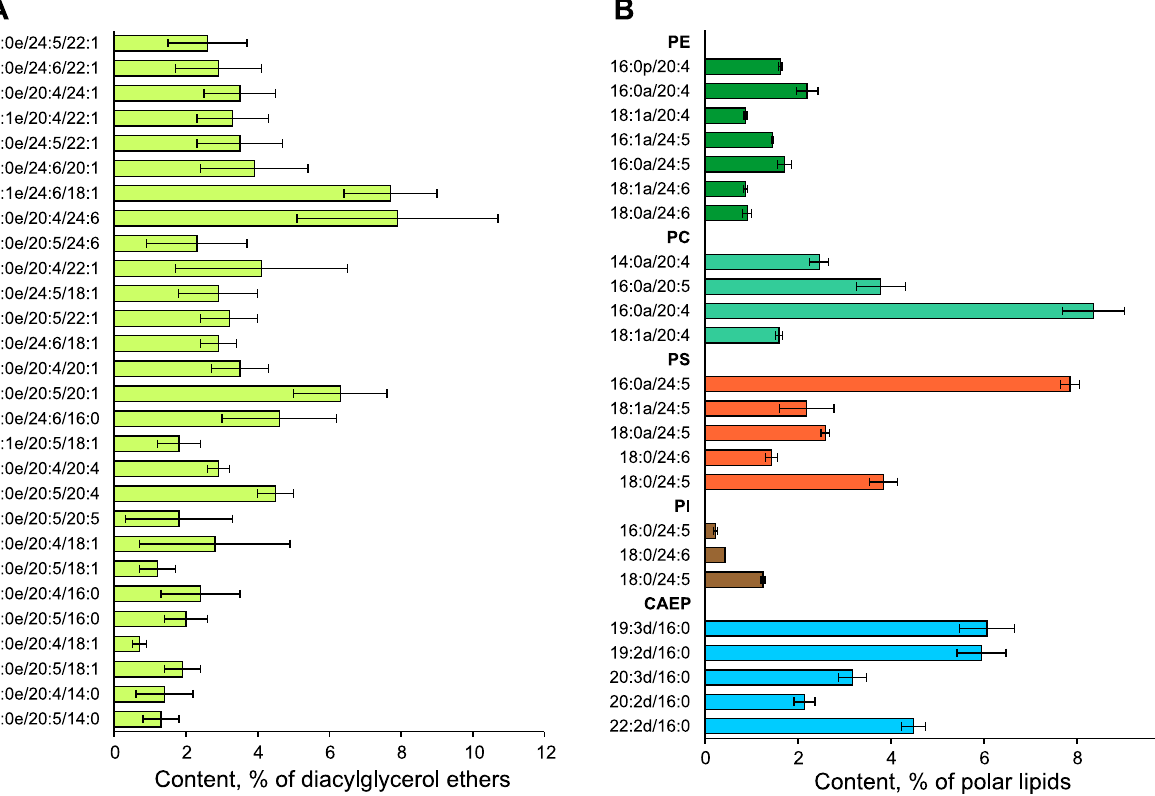
Figure 1. DAGE and polar lipid molecular species. Content of molecular species of ( A ) diacylglycerol ethers (% of total DAGE, mean ± SD, n = 6) and ( B ) polar lipid classes (% of total polar lipids, mean ± SD, n = 3) in the soft coral Paragorgia arborea . The polar lipids are comprised of ceramide aminoethylphosphonate (CAEP), ethanolamine, choline, inositol, and serine glycerophospholipids (PE, PC, PI, and PS, respectively). DAGE molecules are abbreviated as Xe/Y/Z, where Xe is alkyl group, Y and Z are acyl groups (number of carbon atoms : number of double bonds) at sn -1/ sn -2/ sn -3 positions of the glycerol ether backbone. CAEP molecules are abbreviated as Xd/Y; alkyl/acyl, alkenyl/acyl, and diacyl molecules of glycerophospholipids, as Xa/Y, Xp/Y, and X/Y, respectively. Xd, sphingoid base; Xa, alkyl group; Xp, alk-1-enyl group; X and Y, acyl